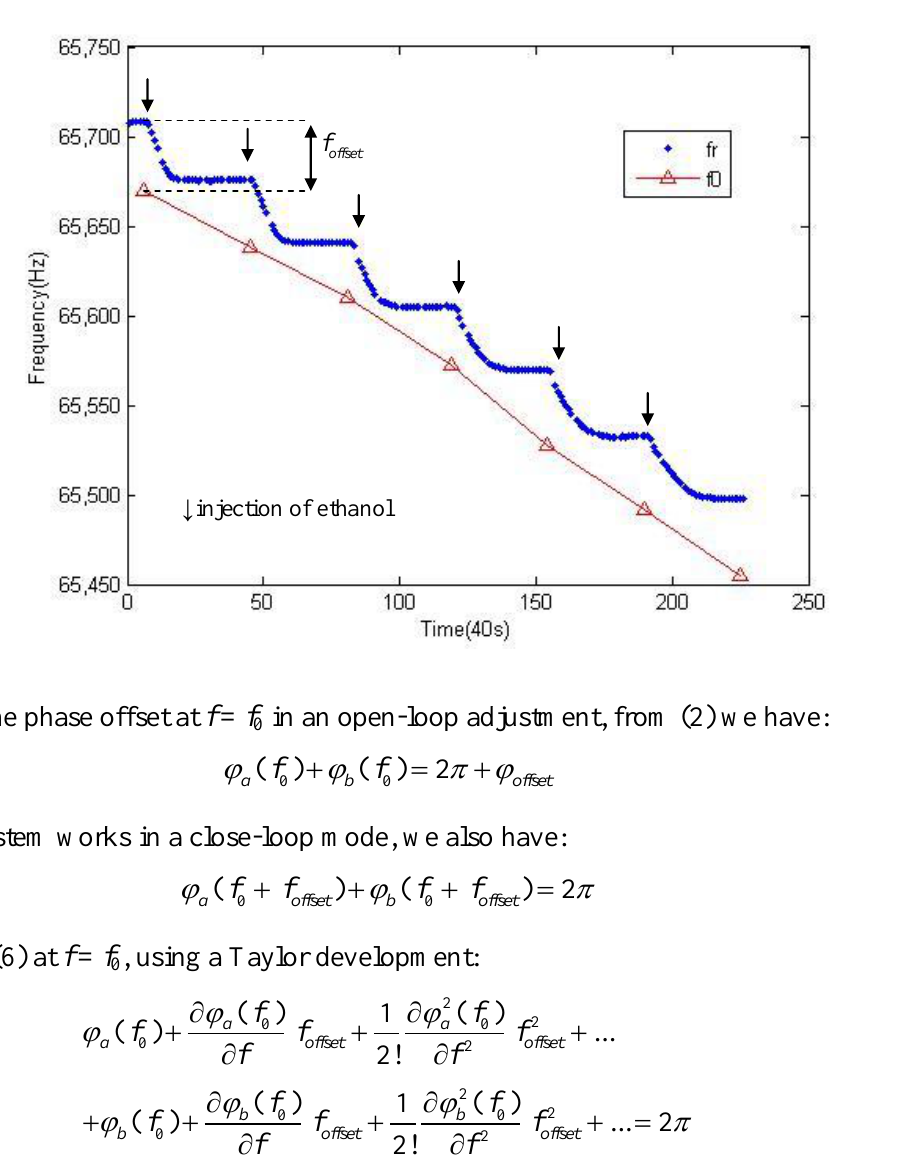
Figure 8. Typical raw data of the frequency shift of a SAD circuit loop and the internal micro-cantilever. To improve the visibility of the data points, the data are sampled with a time step of 40 seconds. The abscissa is time and each unit represents 40 seconds.